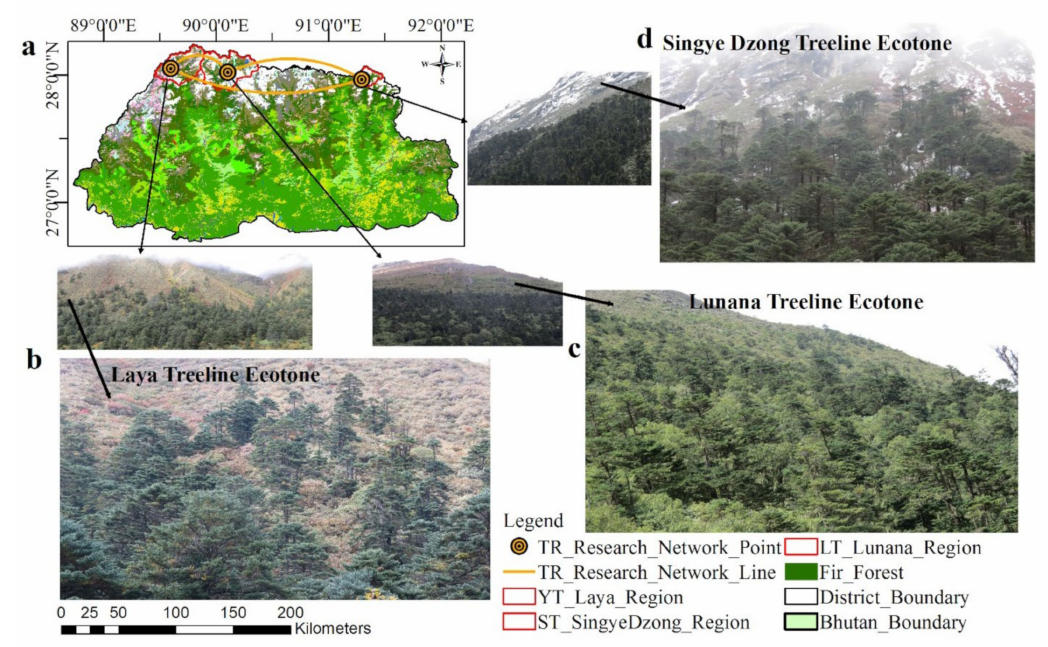
Figure 1. Tree-ring network sites nesting diffuse treeline ecotones in high mountains. Three specific treeline sites (golden concentric circles) and three treeline regions (Lunana, Laya and Singye Dzong- pink shaded polygons) connected by thick curved golden lines. Sampling treeline ecotones of three regions (( b – d ) panels) are in pictorial representation (zoom in and out). Land use types shaded by various colours: fir forest by dark green and glacier/snow covers by white (( a ) panel).